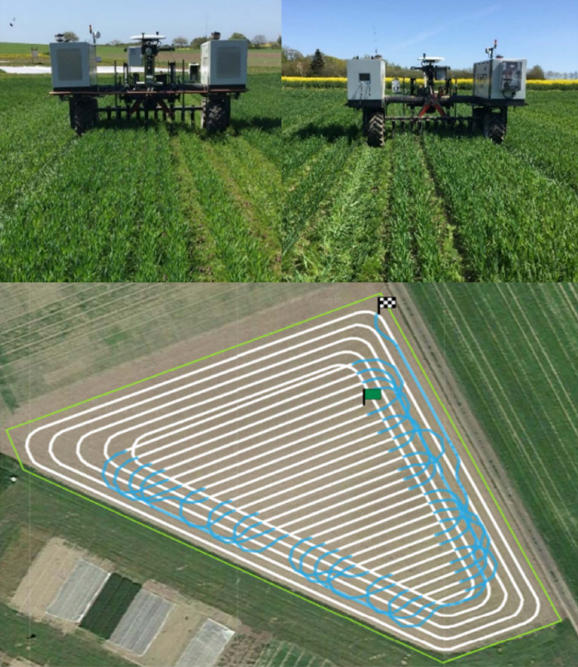
Figure 21. Weeding operation with the robot in a triangle shape